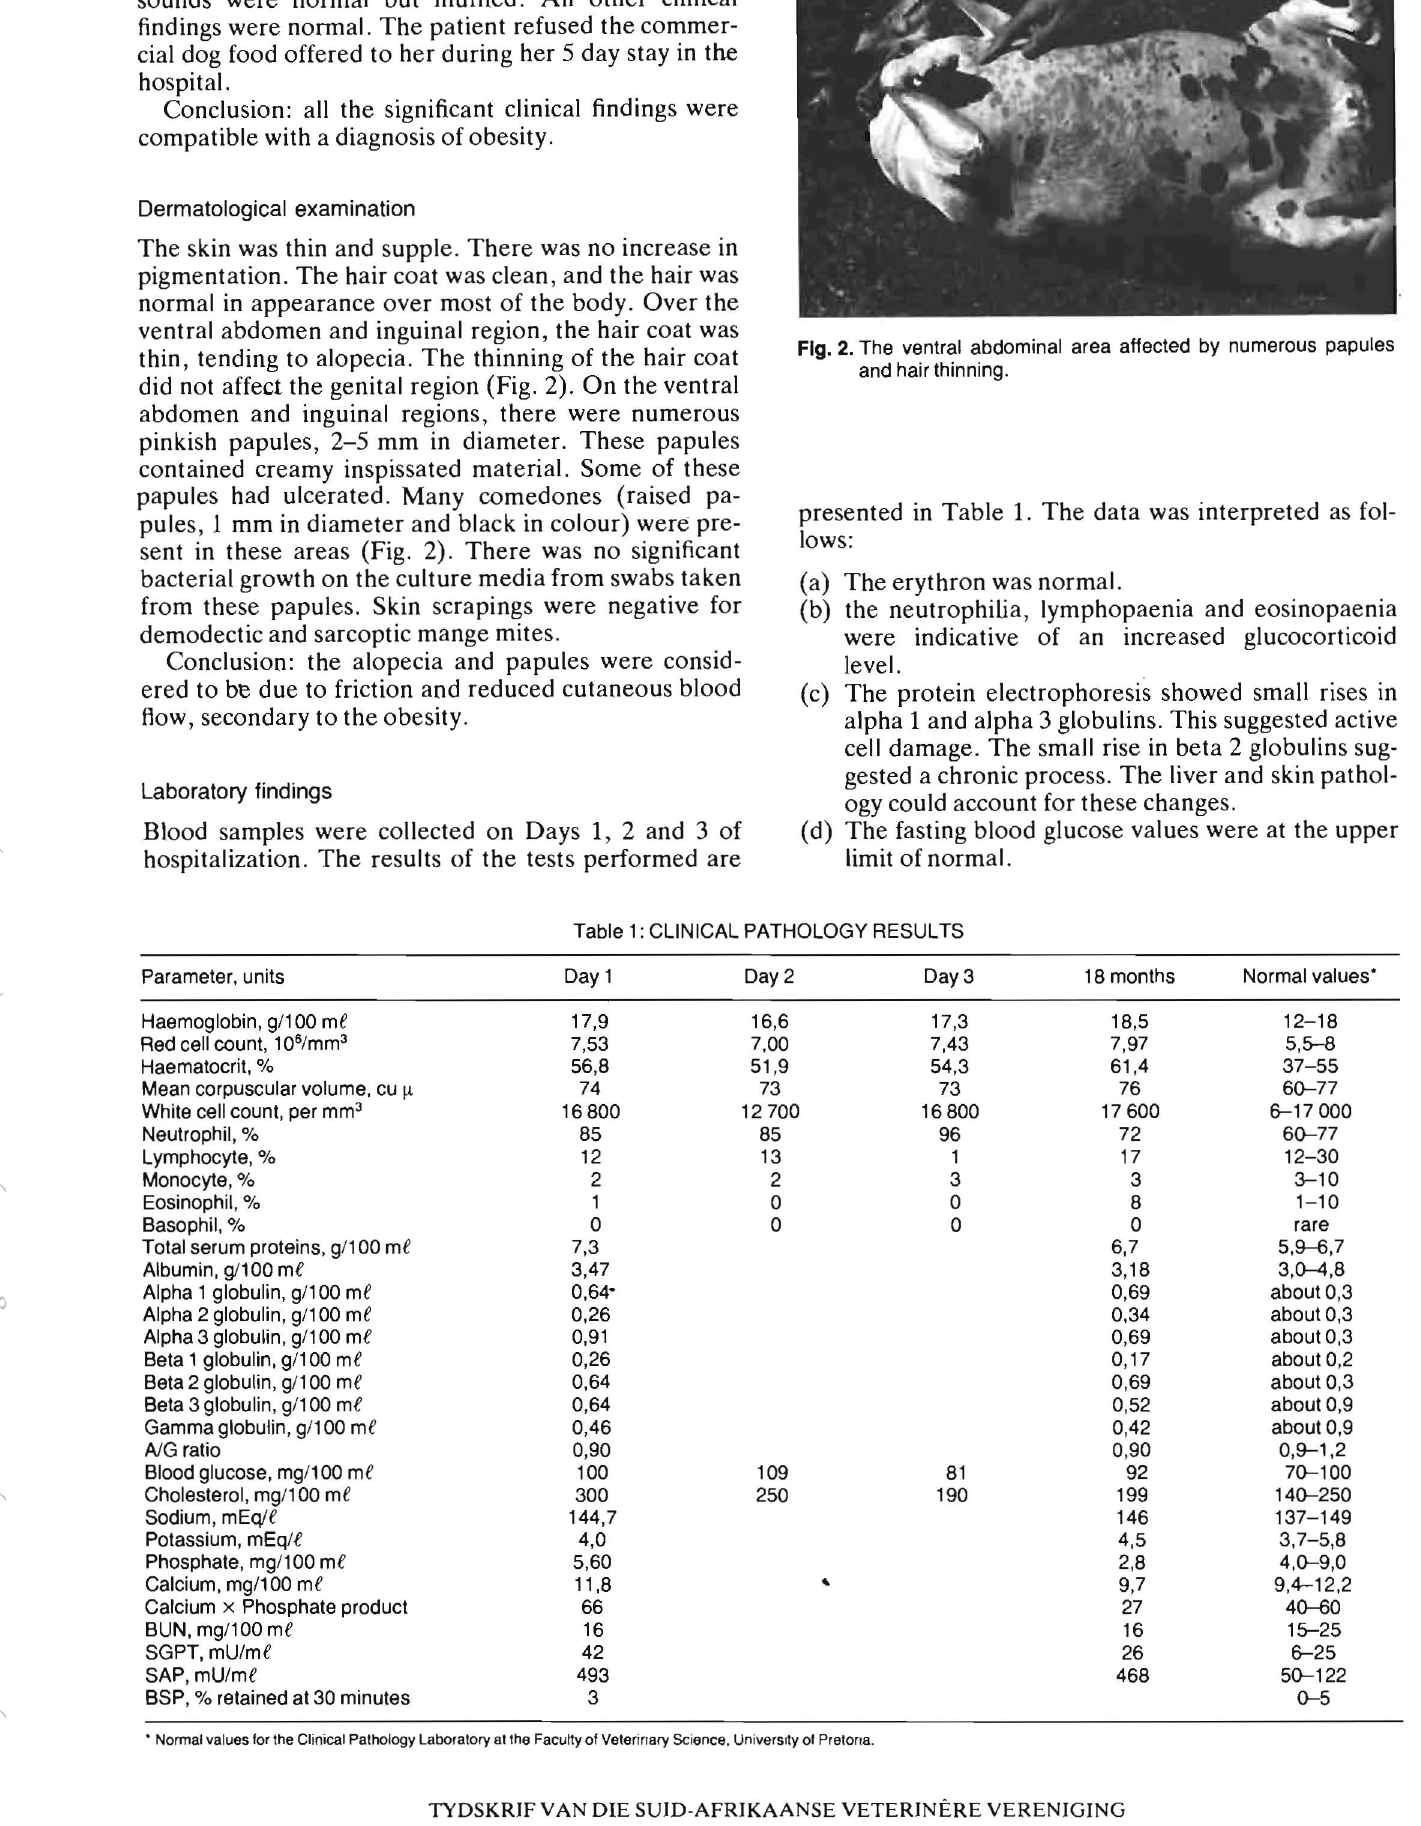
Fig. 2. The ventral abdominal area affected by numerous papules and hair thinning.